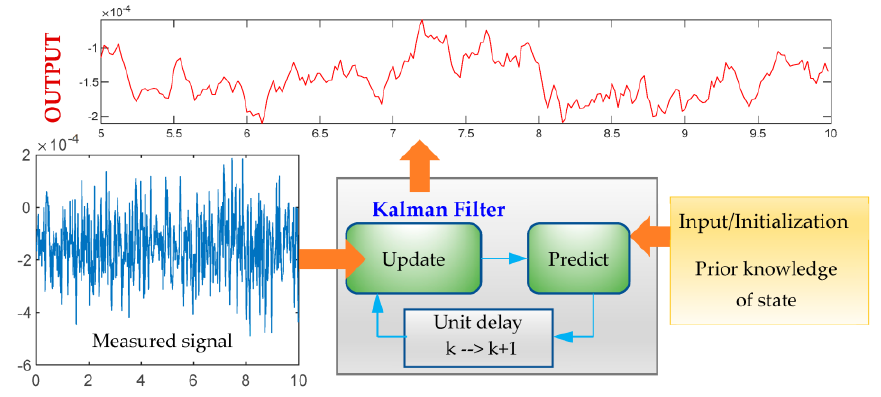
Figure 1. Kalman